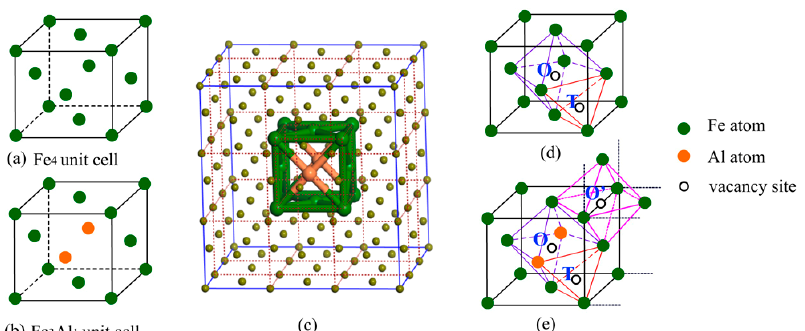
Figure 1. The face-centered cubic (FCC) unit cell of Al-free austenite Fe 4 ( a ), Al-containing austenite Fe 3 Al 1 ( b ), 3 × 3 × 3 supercell of FCC structures for Al-containing austenite ( c ), the interstitial sites in Al-free austenite ( d ) and Al-containing austenite ( e ).